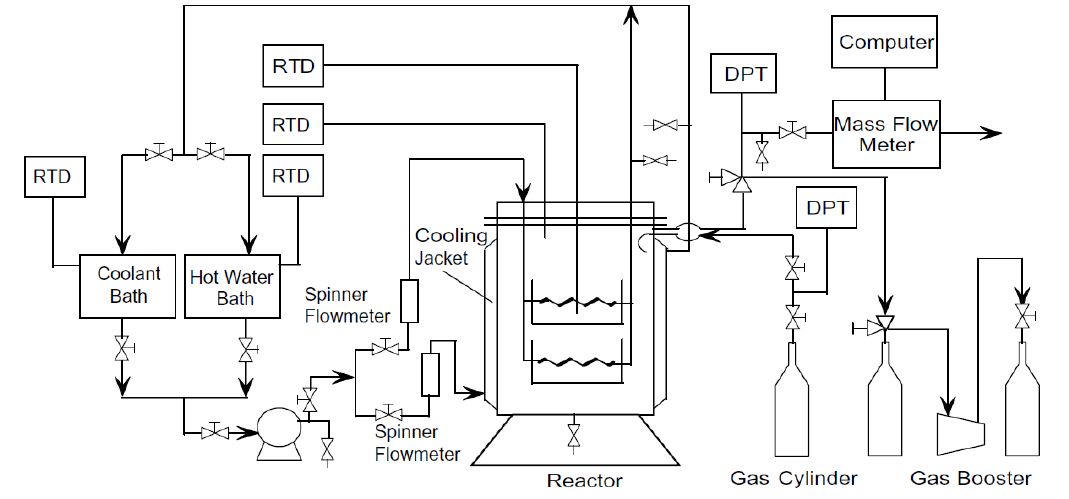
Figure 6. Flow diagram of the experimental apparatus of gas production from hydrates by the thermal stimulation method [69].